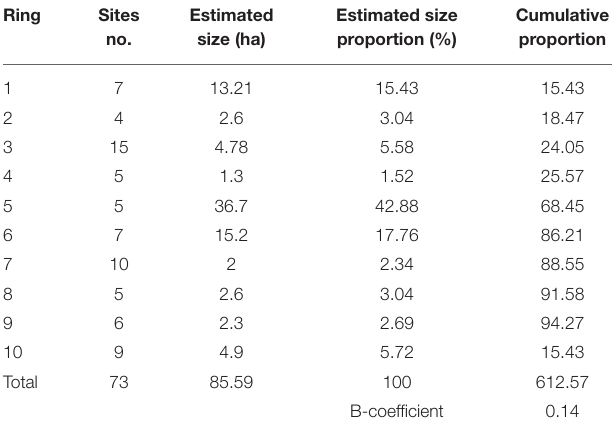
TABLE 13 | Calculation of B-coefficient for Tuscania in the Post-Archaic period. Ring Sites